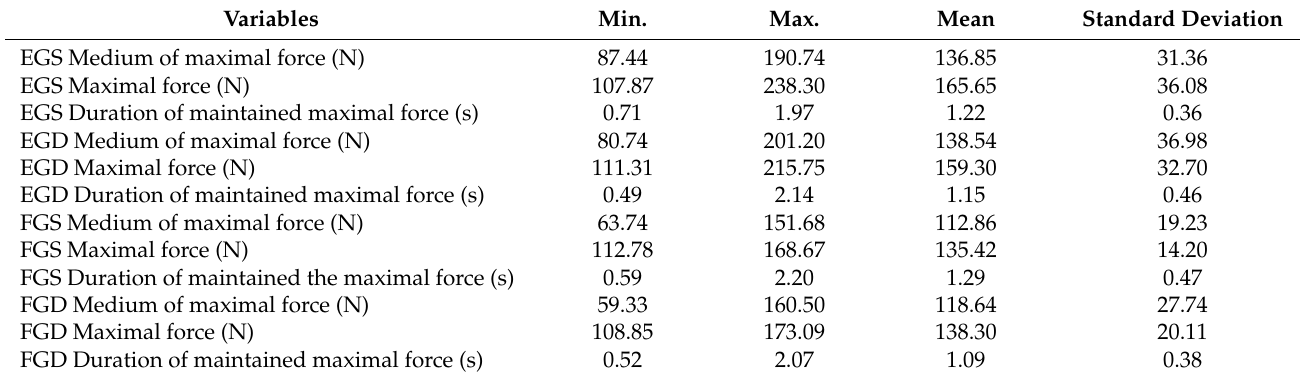
Table 9. Statistical description of muscle force